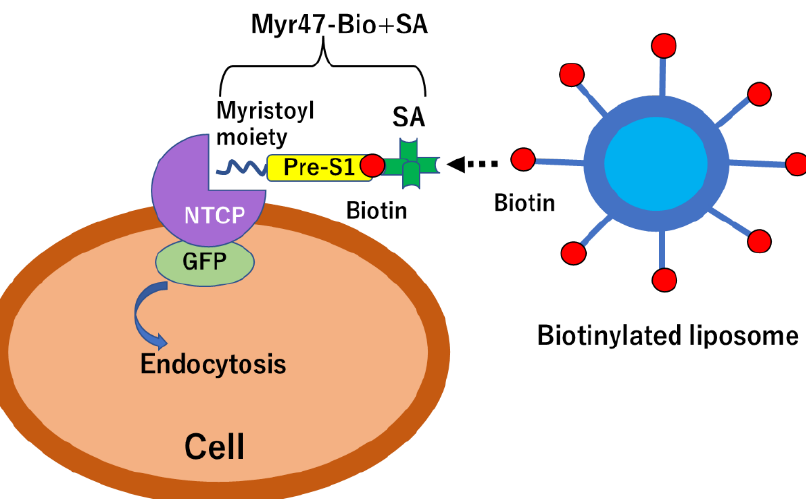
Figure 1. Illustration of liposomal binding and endocytic processes via Myr47 bound to NTCP-GFP expressed on the cell. In the 1st step, a Myr47+SA complex binds NTCP-GFP expressed on the cell. In the 2nd step, biotinylated liposome(s) bind this complex. In the 3rd step, an NTCP-GFP/Myr47- Bio+SA/biotinylated liposome(s) complex is endocytosed into the cell.